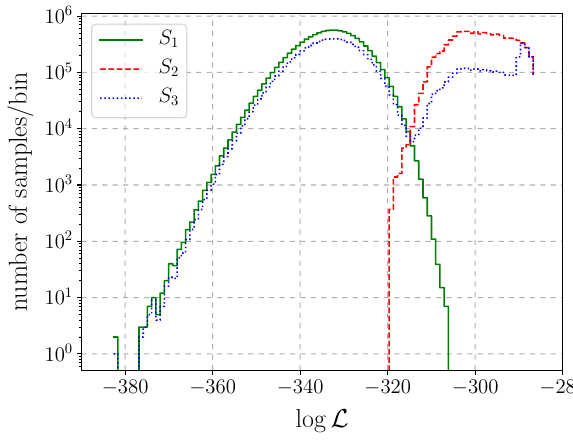
Fig. 4 Evolution of the chains in an emcee3 sampling of the LF in Eq.(11)with200walkersand10 5 stepsusingthe GaussianMove algo- rithm, that updated one parameter at a time, with a variance 5 × 10 − 4 . The plots show the explored values of the parameter μ (left) and of